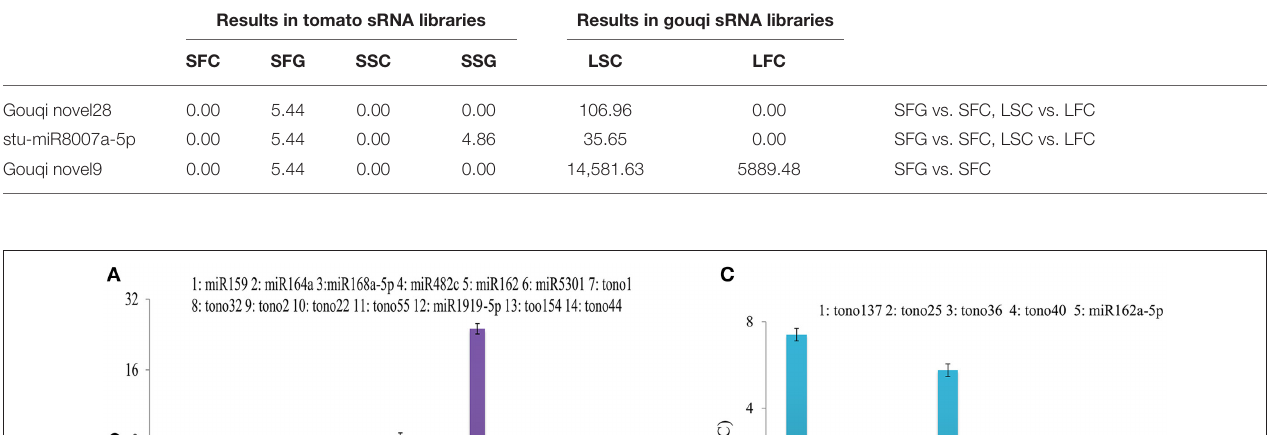
TABLE 5 | Expression pattern of the graft-transmissible miRNAs in the small RNA libraries. miRNAs